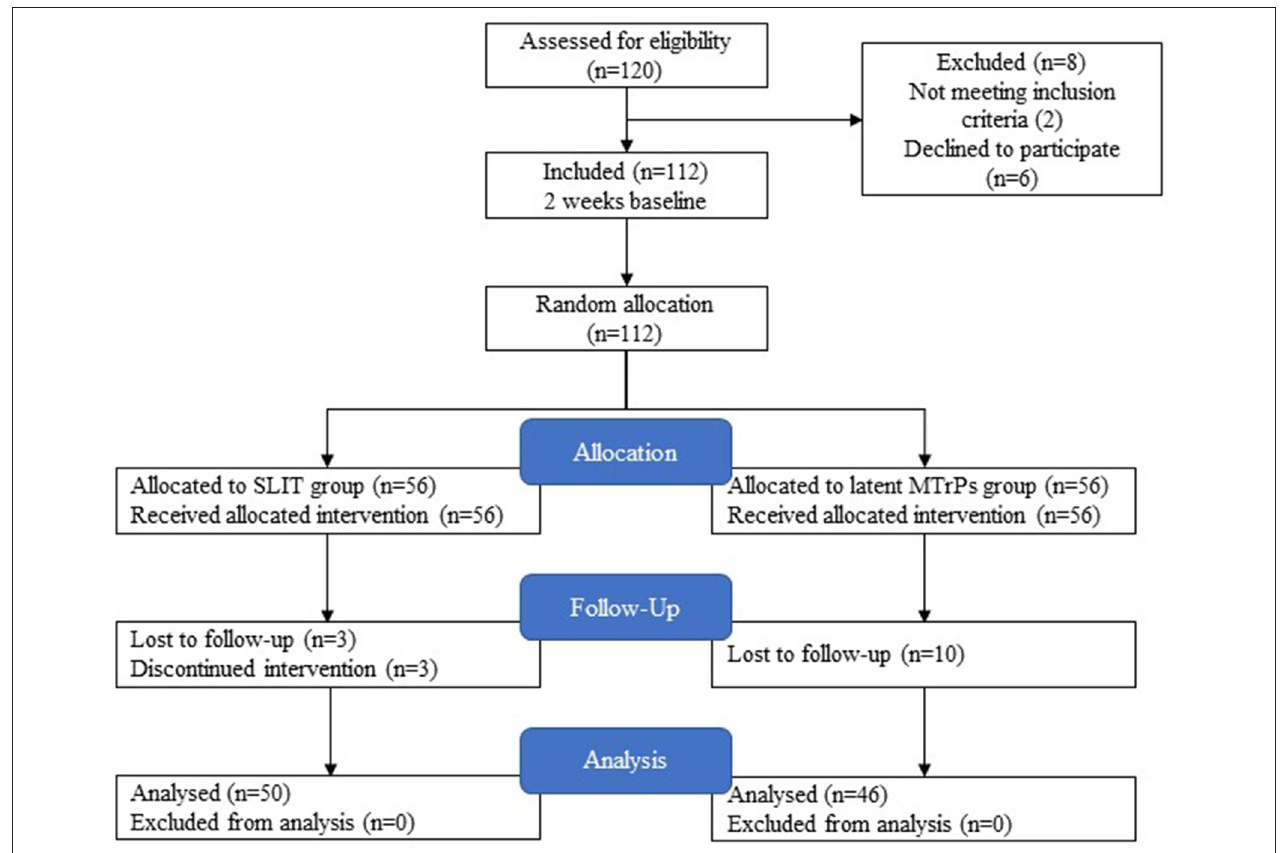
FIGURE 2 | Flow diagram of trial procedure.